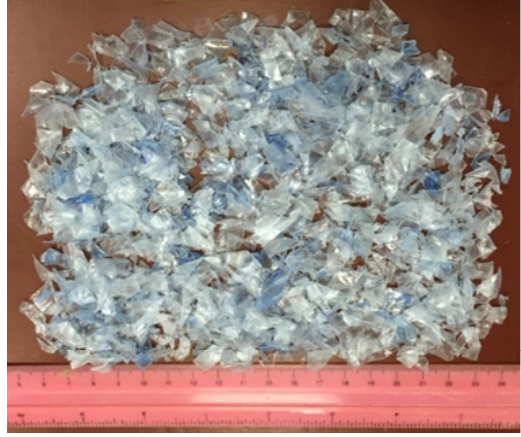
Figure 4. Polyethylene terephthalate (PET) plastics waste used in developing plastic based green lightweight aggregate (PGLA).